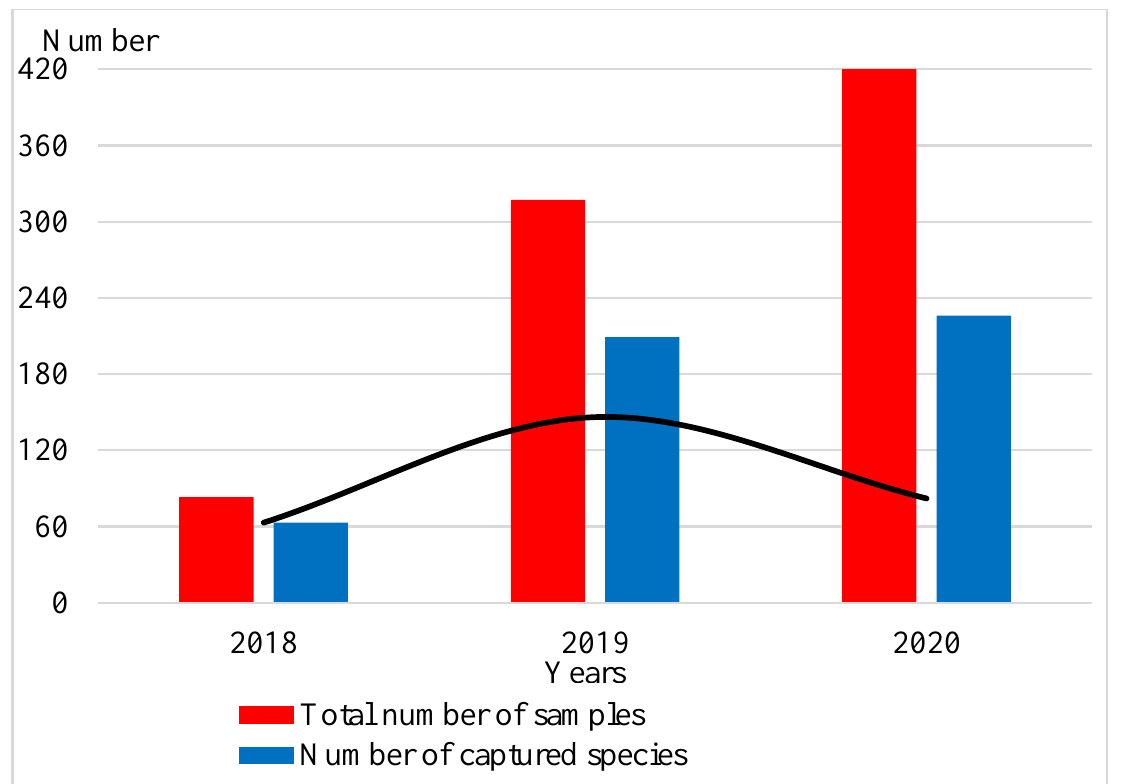
Figure 3. Dependence of the number of captured species on the number of traps by year. Figure 4 shows the same direction of the effects of factors with some variance from Wv (above) to B (below all) for families and for species. It turned out that the number of Curculionidae specimens (mainly due to Anisandrus dispar ) increases when catching with white wine without sugar, and to a lesser extent with red wine without sugar. At the same time, the number of Nitidulidae specimens is not related to these factors, but their catchability increases with all other factors. As for the other families, they are all equally attracted to baits from different mixtures. Thus, the Dermestidae, Scarabaeidae,